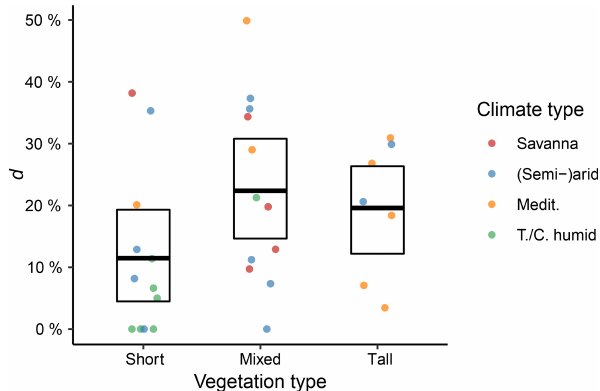
Figure 8. Fraction of relative ET reduction during dry-down events ( d ; Eq. 18). The points represent the values for individual sites, the bold bar denotes the mean value of all sites, and the box represents the bootstrapped 95% confidence